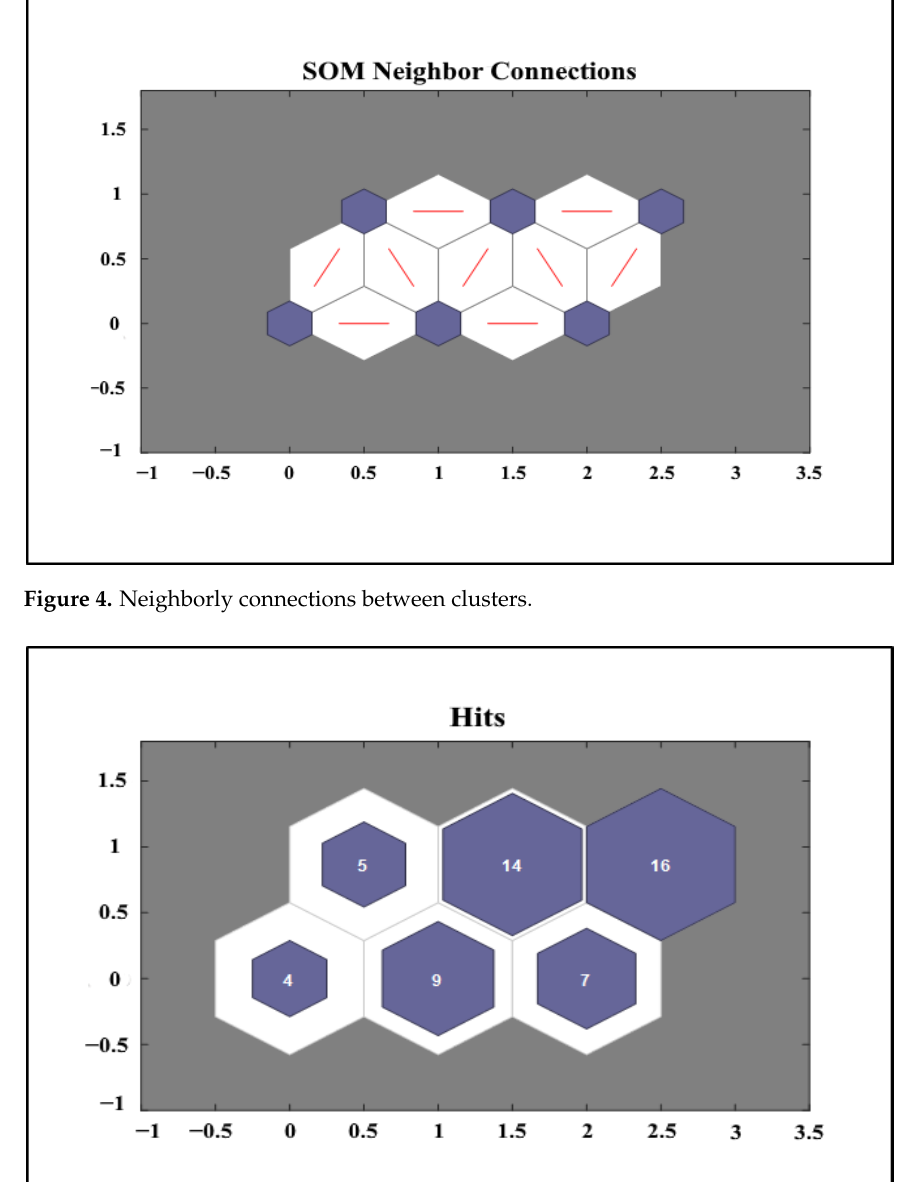
Figure 3. Graph of distances between neighboring neurons in the SOM network. Note: Colored areas represent individual clusters.